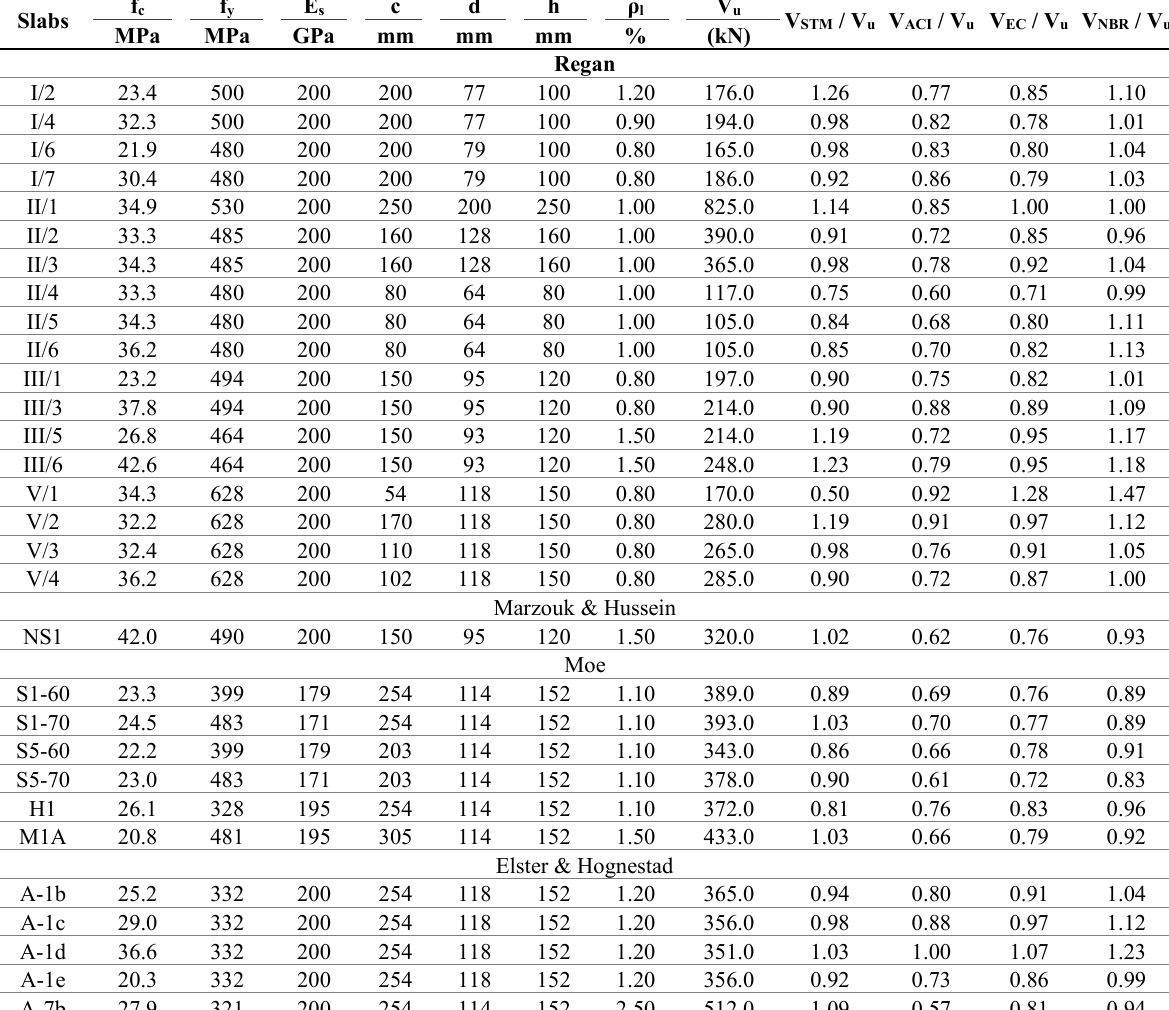
Table 3. Data and experimental results from slabs of Regan [5], [6], [7], Marzouk & Hussein [14], Moe [15] and Elster & Hognestad